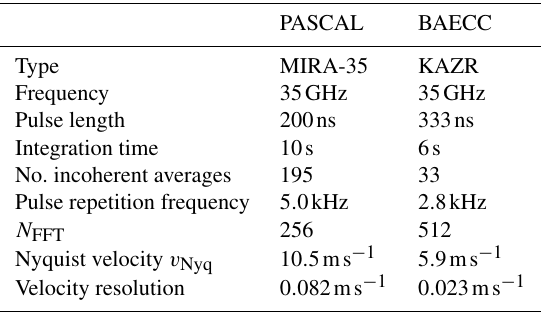
Table 1. Configuration settings of the two cloud radars used in this study.